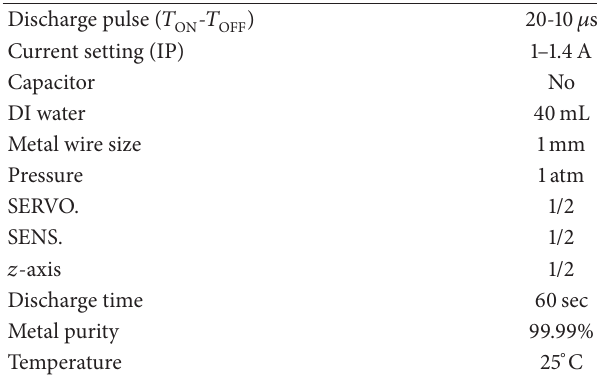
Table 1: Nanosilver colloid preparation